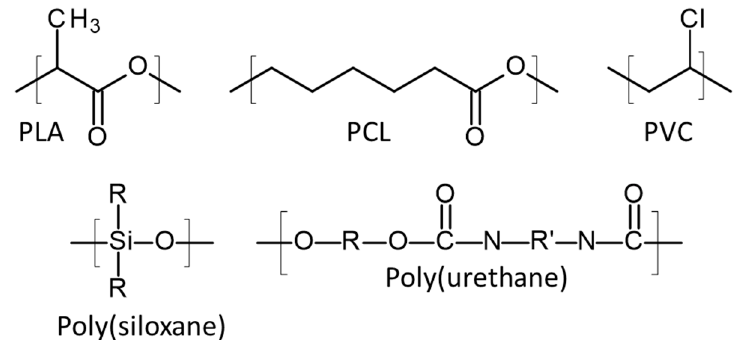
Figure 6. Chemical structures of poly(lactic acid) (PLA), poly(caprolactone) (PCL), poly(vinyl chloride) (PVC), poly(siloxane), and poly(urethane).